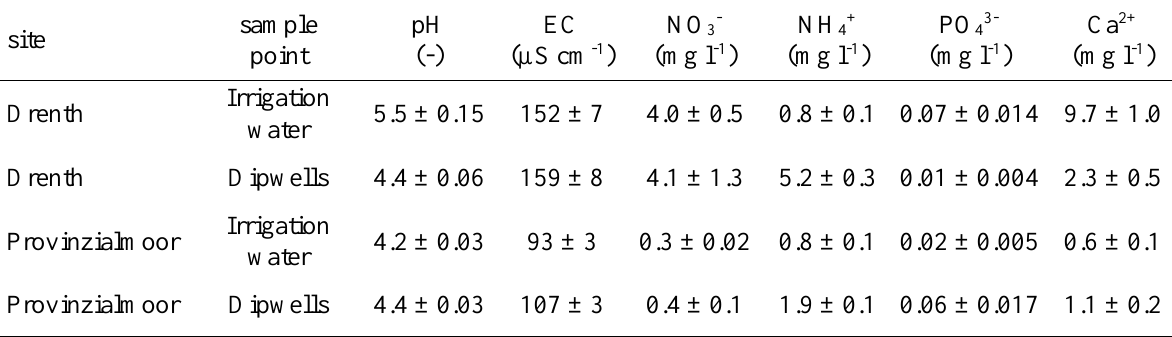
Figure 5. Comparison of the water table (cm) below peat surface of the study sites Drenth and Provinzialmoor between January 2016 and November 2018. The thick line shows the mean value of measured values at each site and the shade shows the range (min to max). Table 1. Mean values ± standard error (SE) of water quality at the study sites Drenth and Provinzialmoor measured in the irrigation water and dipwells between March 2017 and March 2019 (details in Oestmann et al. 2021); EC = electrical